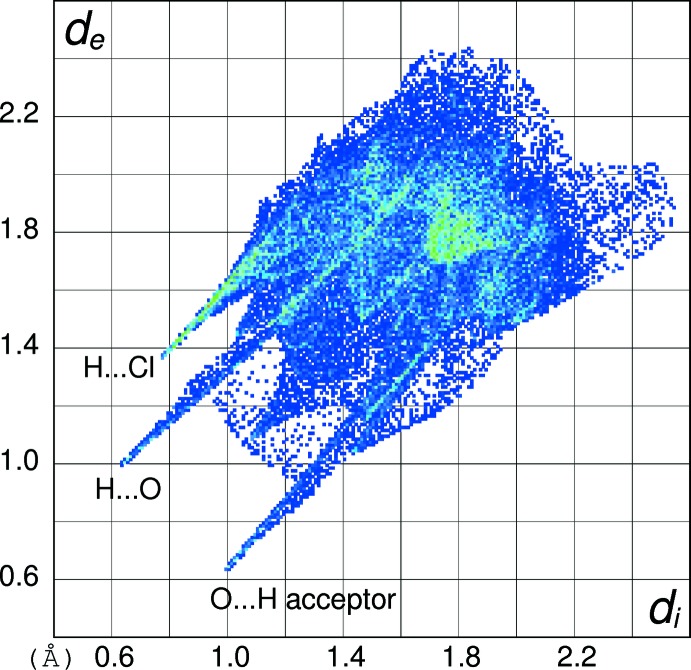
Hirshfeld fingerprint plot for the C7H9N2O2
+ cation in (I).